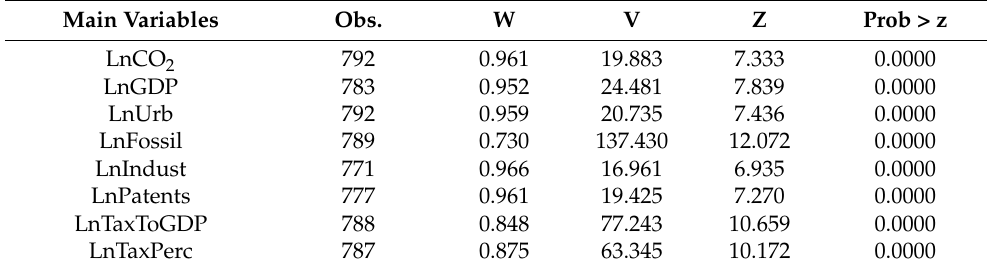
Table 3. Normality test (Shapiro–Wilk test).